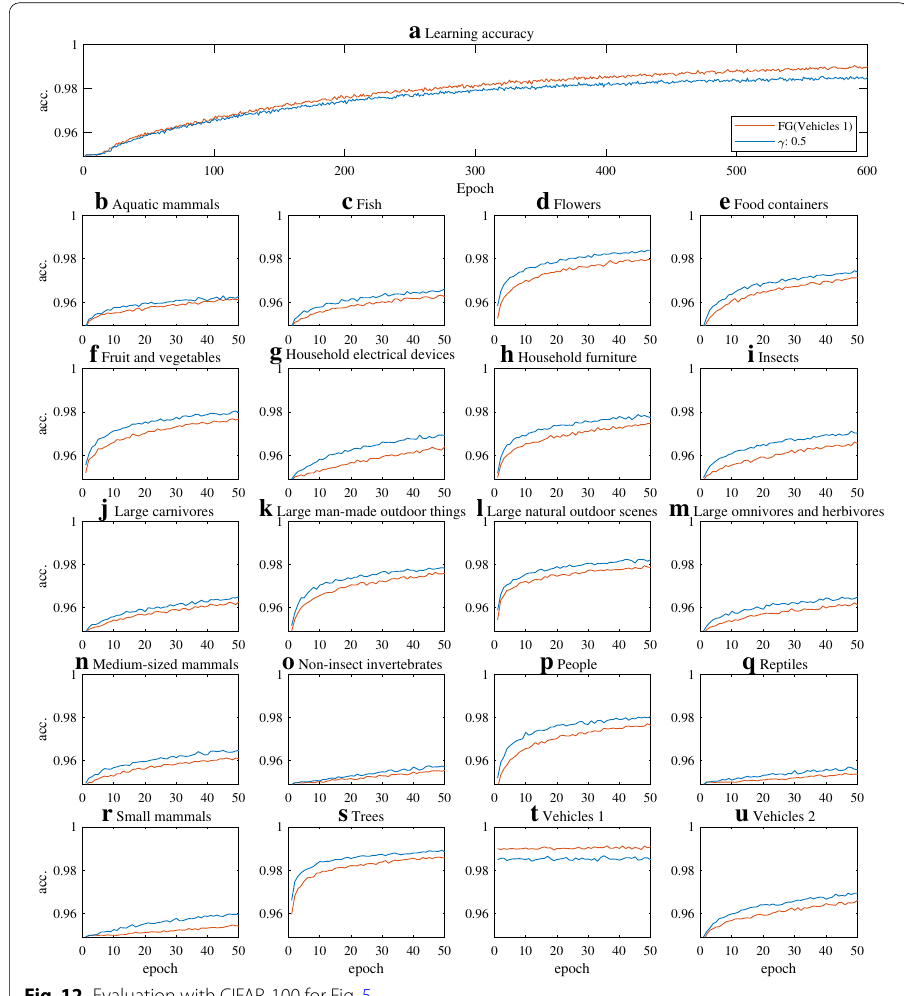
Fig. 12 Evaluation with CIFAR-100 for Fig.